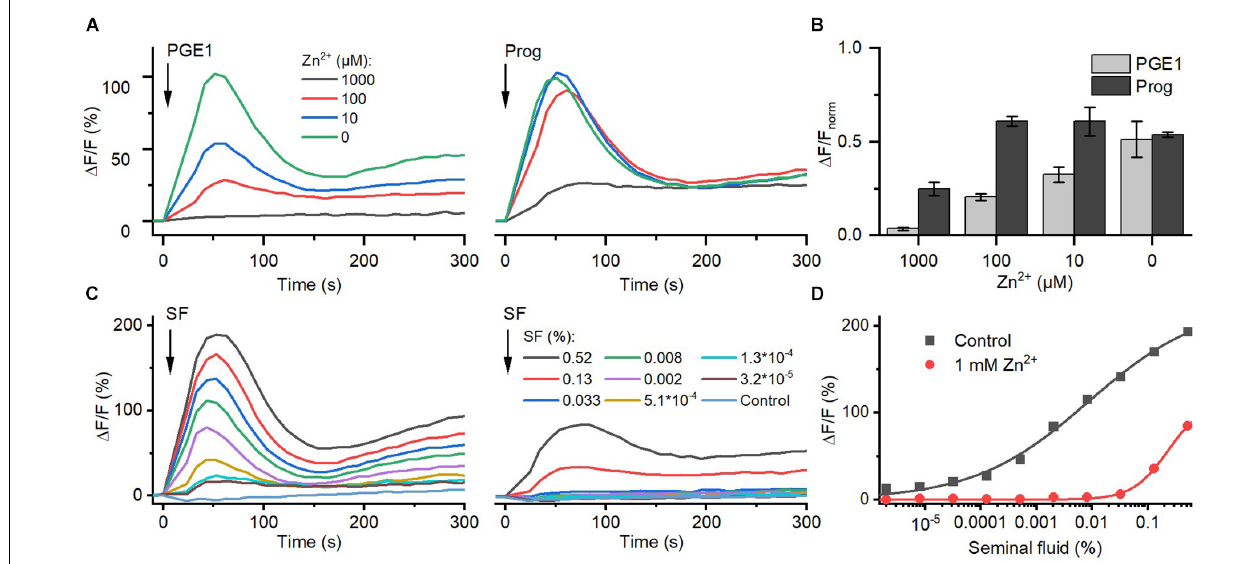
FIGURE 6 | The action of Zn 2 + on prostaglandin- and steroid-evoked Ca 2 + signals in human sperm. (A) Representative Ca 2 + signal evoked by progesterone (3 µ M) and PGE 1 (3 µ M) in the absence and presence of different Zn 2 + concentrations. (B) Mean ( ± SD) maximal amplitude of Ca 2 + signals evoked by progesterone and PGE 1 in the presence of indicated Zn 2 + concentration normalized to the amplitude of the ionomycin-evoked Ca 2 + signal recorded in parallel. (C) Representative seminal fluid-evoked Ca 2 + signals in the absence (left) and presence (right) of Zn 2 + (1 mM). (D) Concentration–response relationship for the maximal amplitudes of Ca 2 + signals shown in (B) .